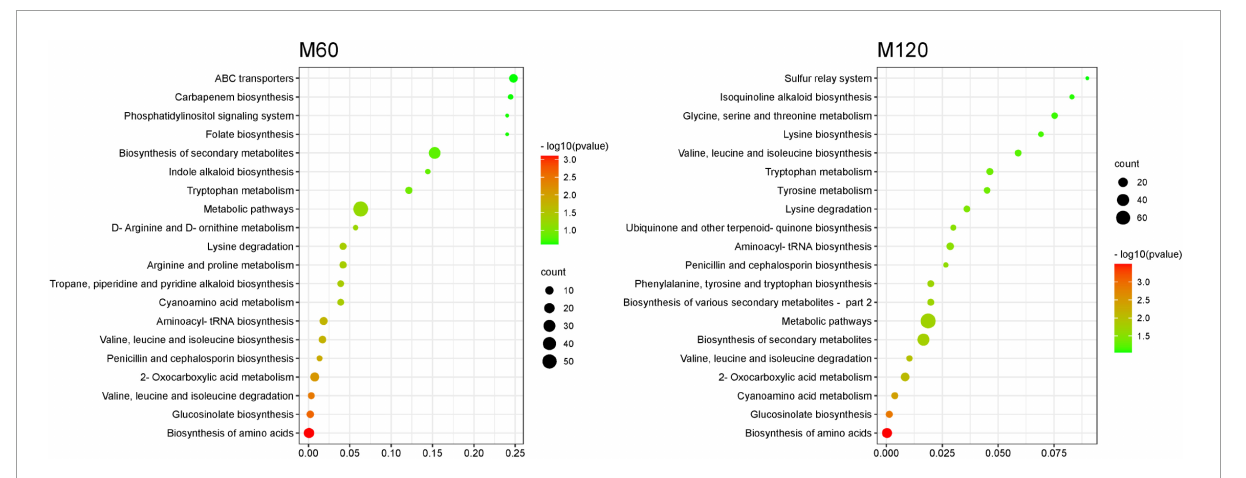
FIGURE8 Top 20 pathways of KEGG enrichment of SRMs in